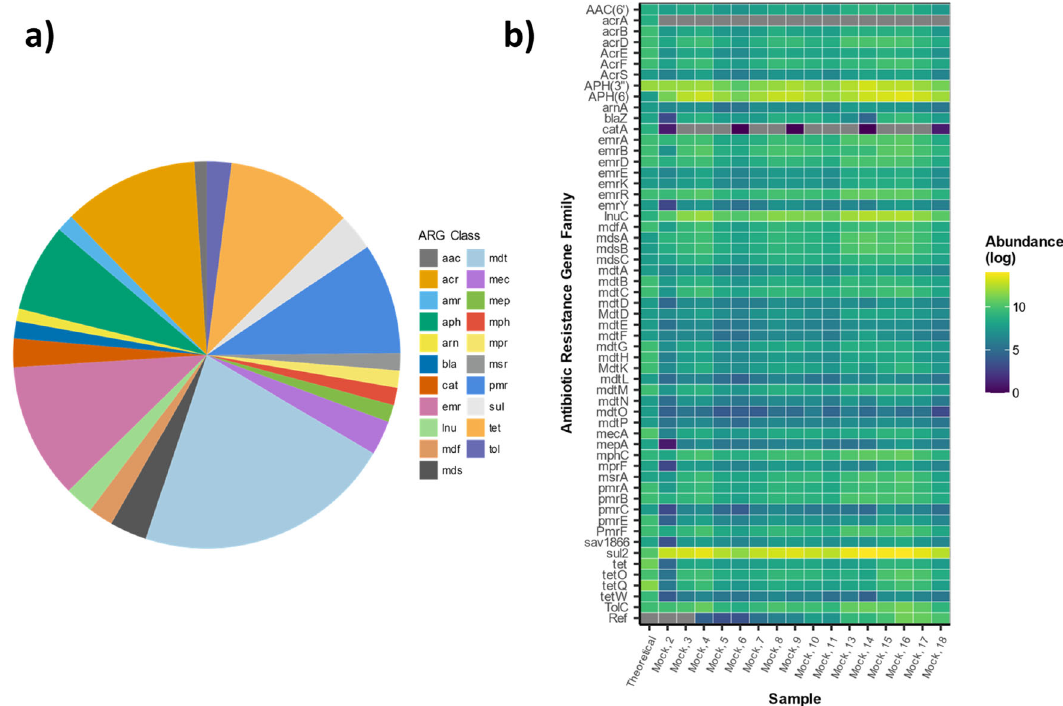
Fig. 2 Presence and distribution of known ARGs within mock-community samples. a The proportion of the resistome known to be represented by each ARG class based on sequenced genomes. b Heatmap depicting the log-transformed relative abundances of each ARG family from each mock sample and the theoretical distribution within genomes.